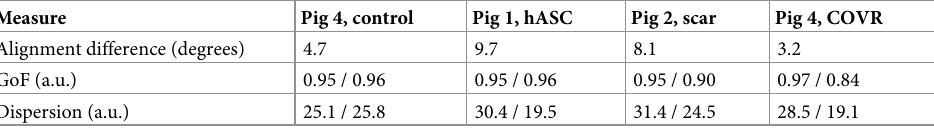
Table 3. Parameters calculated from directionality distributions for collagen / elastin in all SHG images.